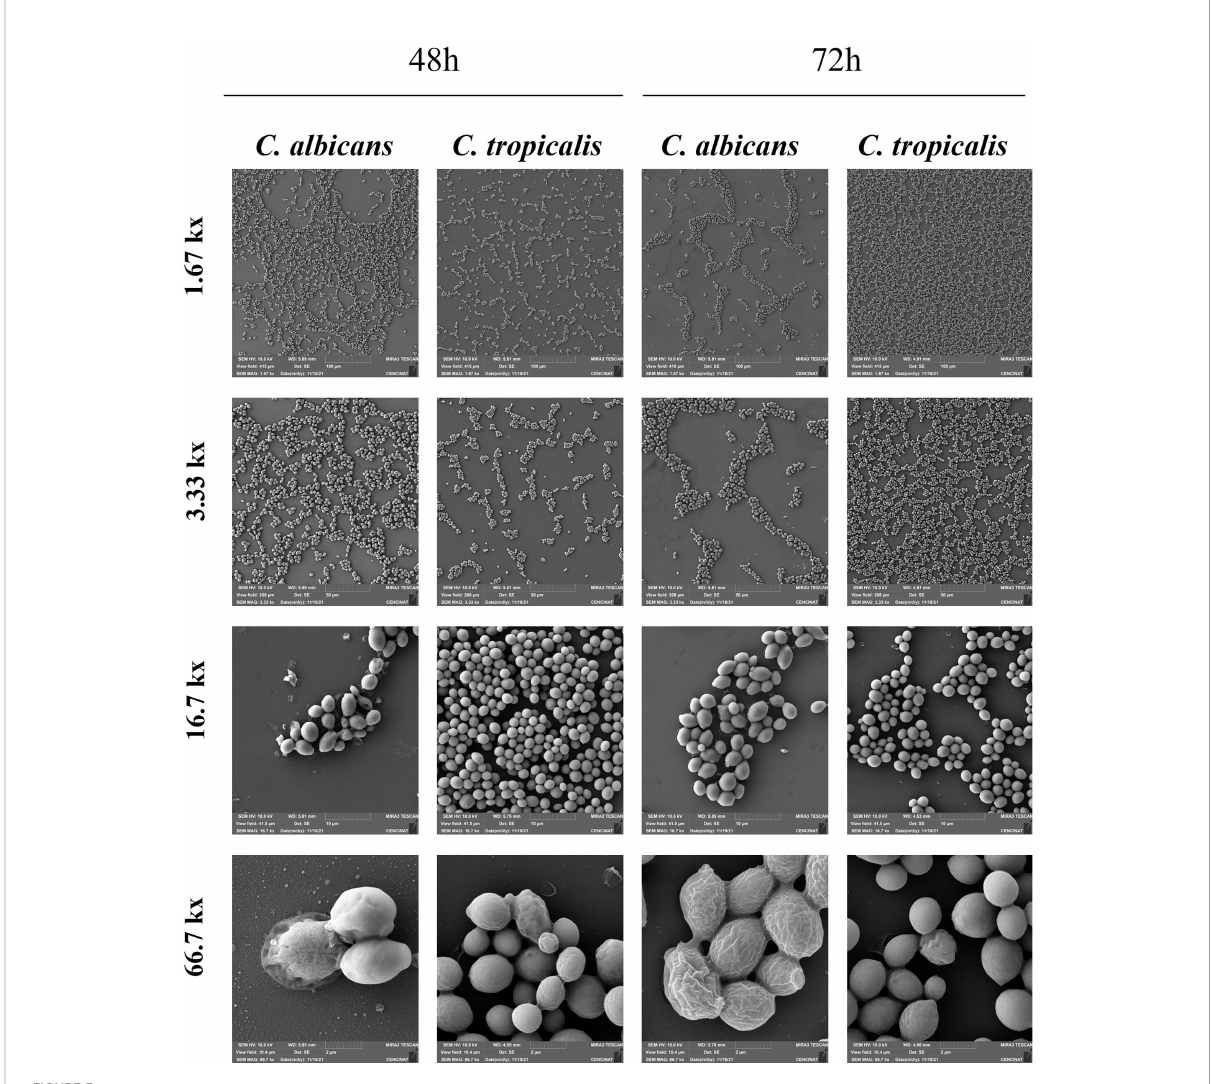
FIGURE 3 Illustration of the bio fi lms of C. albicans and C. tropicalis at 48 and 72 h of growth by scanning electron microscopy using different magni fi cations (1.67, 3.33, 16.7, and 66.7 kx). Time samples of 48 and 72 h were used to compare the bio fi lm structure as well as cell morphology and area of the bio fi lms using a Tescan Mira 3 scanning electron microscope equipped with a Schottky fi eld emission gun (Schottky FEG-SEM). Yeast cell area was calculated from the best pictures by Fiji ImageJ version 1.57 (Schindelin et al.,